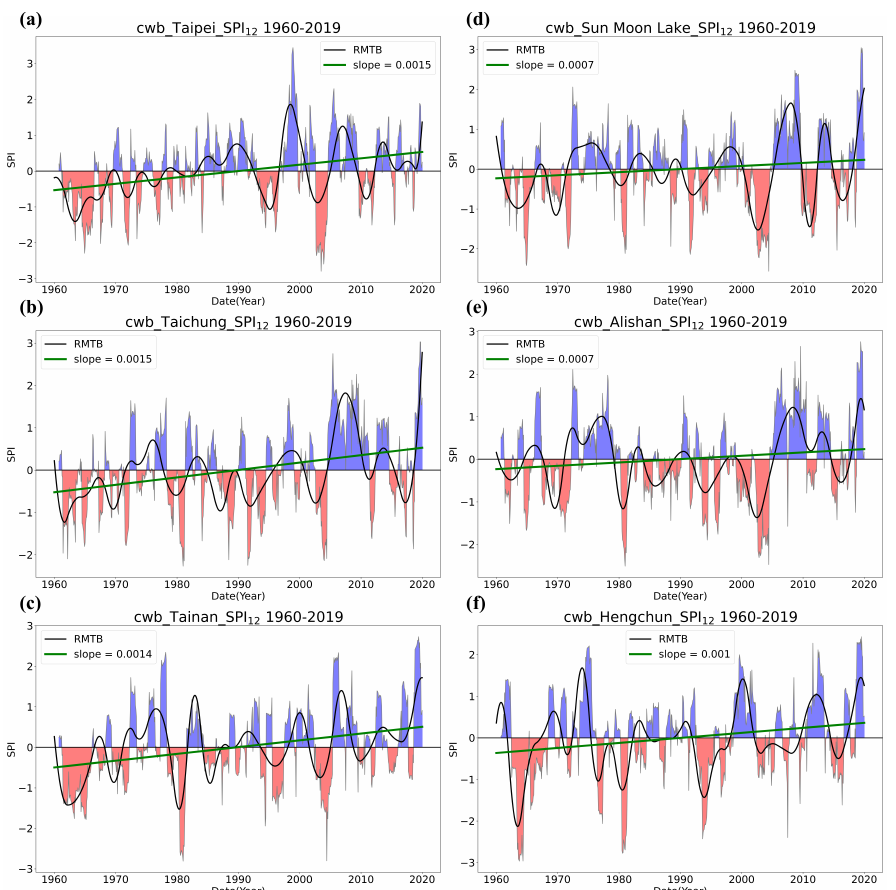
Figure 5. SPI12 time series along with the best fitting linear trend lines and RMTB curves at six CWB stations located over the ( a – c ) western, ( d , e ) mountainous, and ( f ) southern regions of